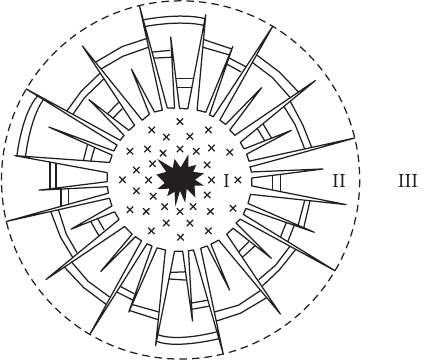
Figure 1: Blasting zones partitioned in the rock, indicating the (I) crush zone, (II) fracture zone, and (III) elastic vibration